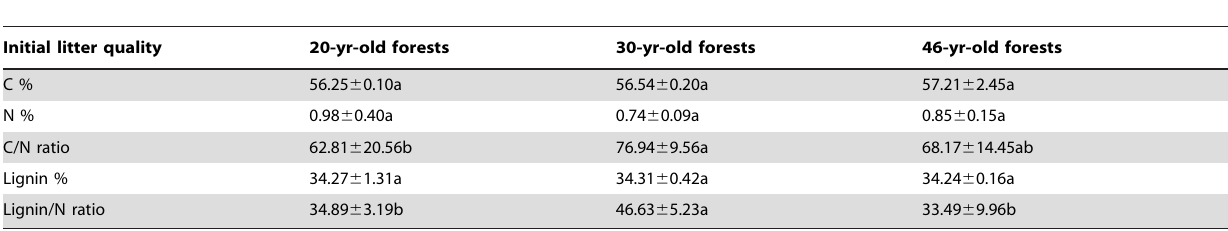
Table 2. Initial substrate quality (mean 6 1SD, n =3) of leaf litter in Pinus massoniana forests